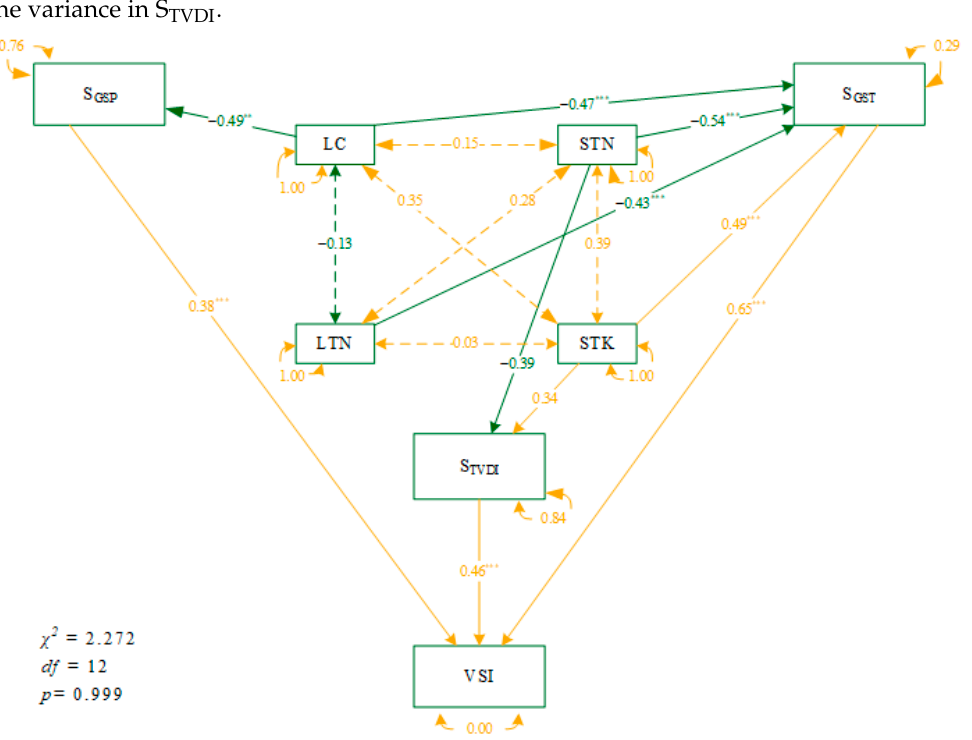
Figure 6. Structural equation modeling reveals the direct and indirect effects of leaf traits and soil properties on VSI and its components of desert scrubs across the Qaidam Basin. Notes are the same as in Table 1. The orange and dark-green lines represent the positive and negative influences, re- spectively. The difference significant at the 0.001 and 0.01 levels were indicated with *** and **, respectively.